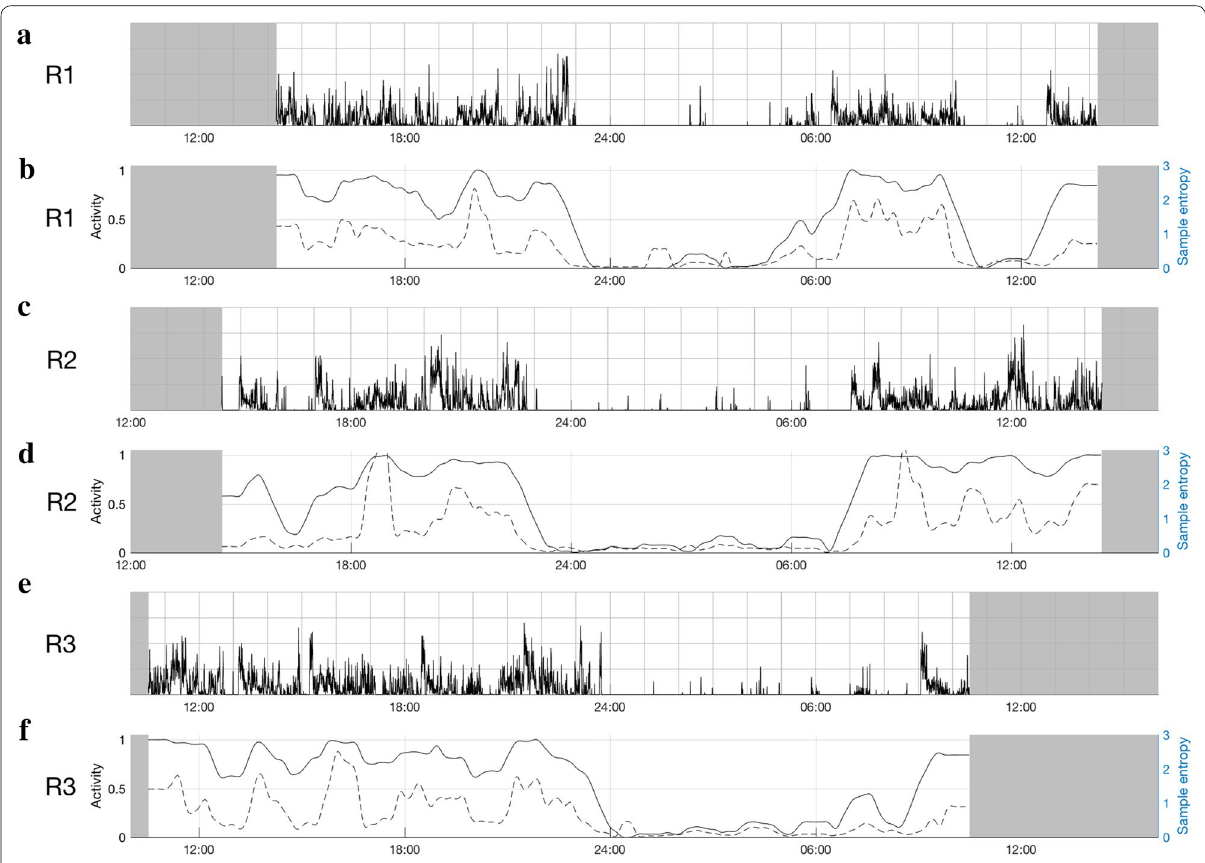
Fig. 2 Actigraphy data for three admissions for a mixed state (case 2). a , b Represent the first recording (R1); c , d the second recording (R2) and e , f the third recording (R3). Time of day is shown at the bottom of each chart (24‑h clock). Light grey parts at the beginning and end of each chart rep‑ resent non‑monitoring time; a , c , e are 24‑h actograms: activity counts are shown as black, vertical lines on a scale from 0 to 500 counts. One square in the grid represents 1 h on a horizontal axis and 125 counts on a vertical axis. b , d , f The ratio between rest and activity as the fully drawn line (left axis) and sample entropy as the dotted line (right